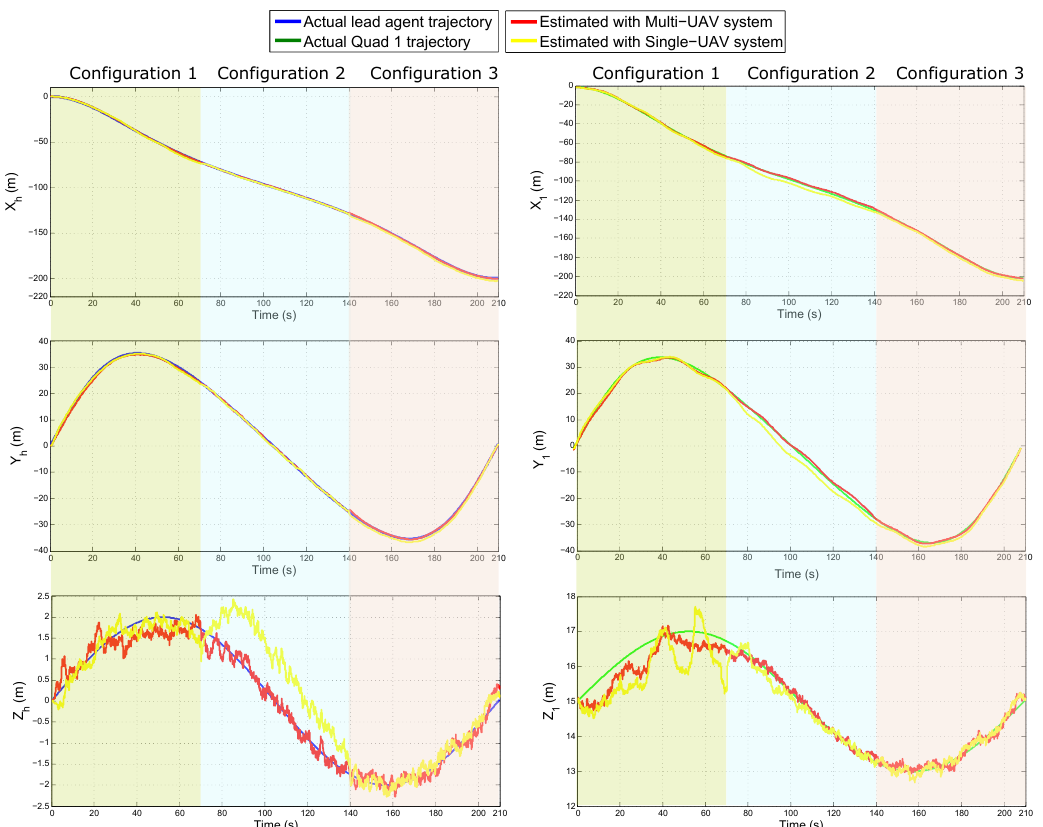
Figure 9. Estimated state of the lead agent ( left plots ) and of the Quad 1 ( right plots ), for both kind of system, under the three